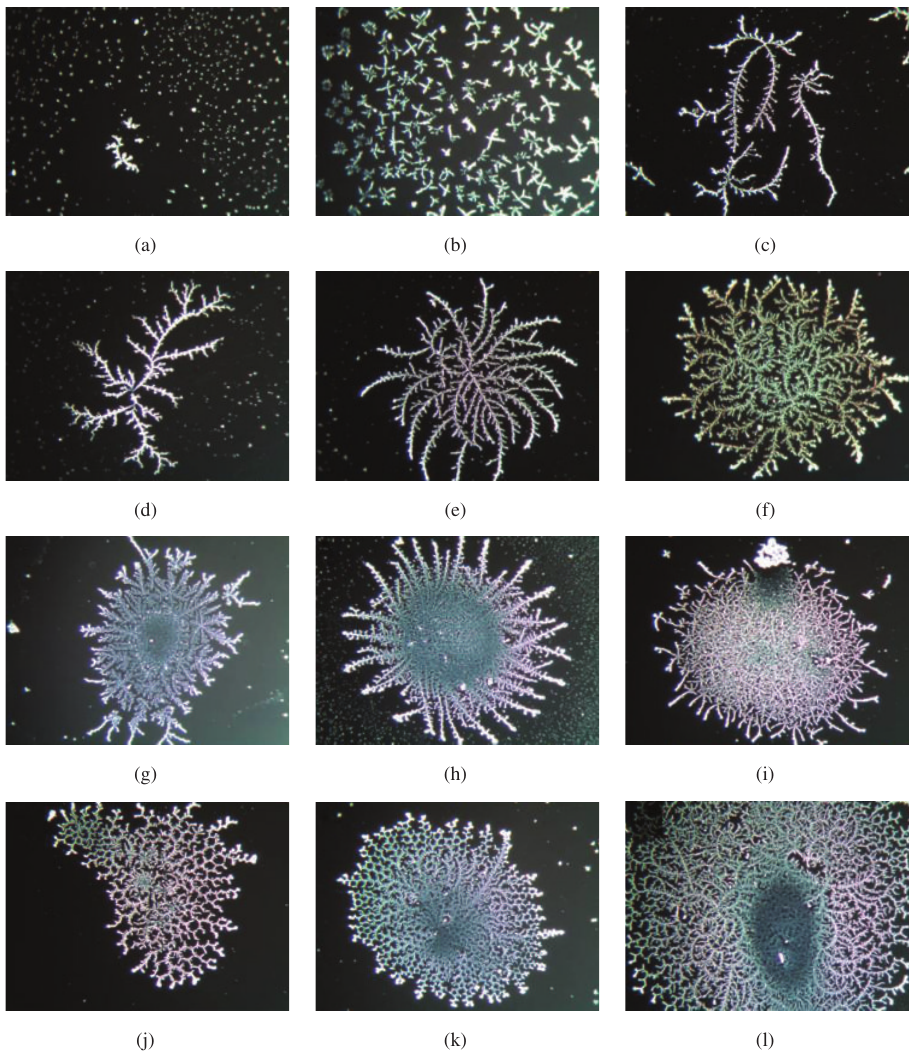
FIGURE 4: Examples of crystalline structures showing different degrees of complexity (magnification 100X): single spots and crosses (a, b), dendrites (c, d), ramified complex structures (e, f), structures containing agglomerates (g, h), complex structures with short disordered ramifications (i), high organized fractal-like structures containing hexagons (j, k), and curled branches